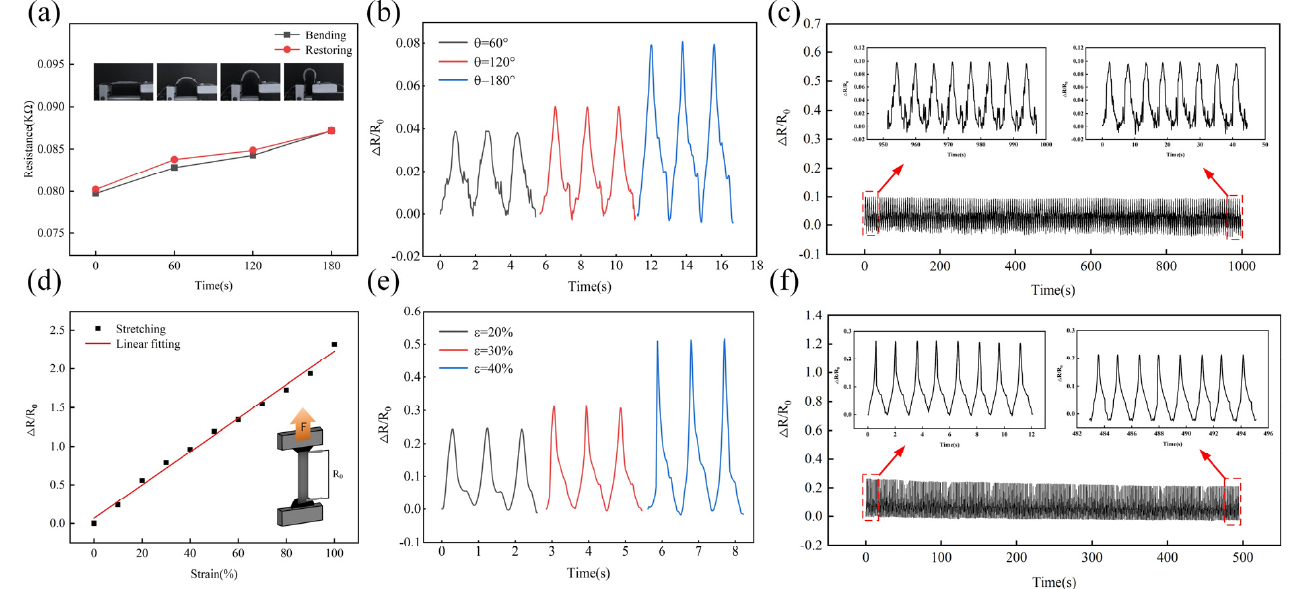
Figure 6. ( a ) Relative resistance change of strain sensor during bending/restoring process; ( b ) dynamic response of strain sensor under different angle bending/restoring cycles; ( c ) cyclic stability of strain sensor under 180° bending/restoring cycles; ( d ) relative resistance change of the strain sensor during stretching process; ( e ) dynamic response of strain sensor under different strain stretching/releasing cycles; and ( f ) cyclic stability of strain sensor under 40% stretching/releasing cycles.